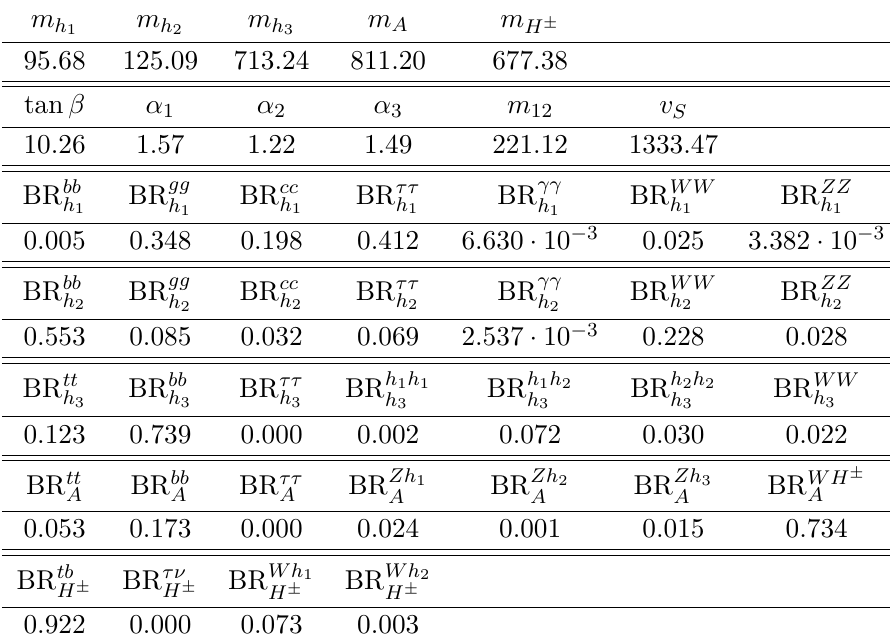
Table 1 . Parameters of the best-fit point for which the minimal value of χ 2 is found ( χ 2 = 88 . 07 , χ 2 = 86 . 24 ) and branching ratios of the scalar particles in the type IV scenario. Dimensionful 125 parameters are given in GeV, and the angles are given in